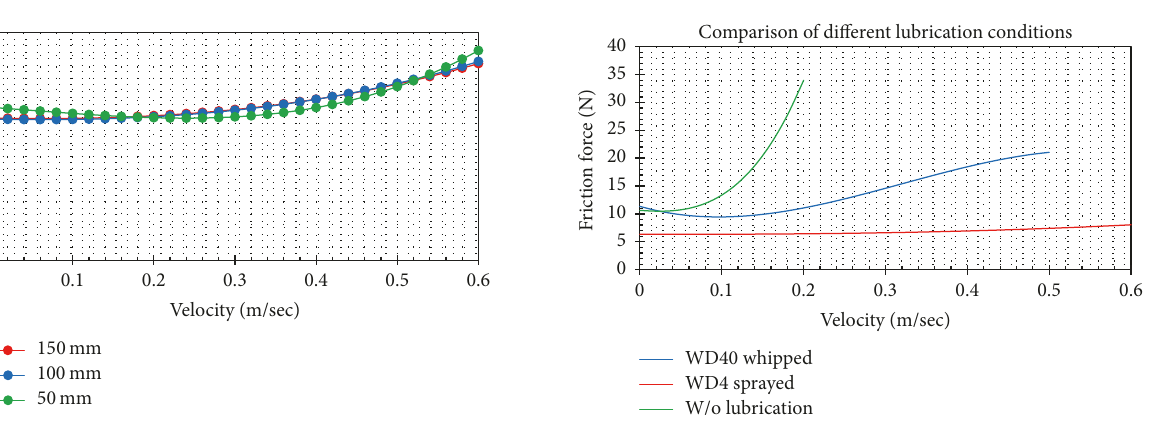
Figure 7: Function of individual best fit and friction force and function of overall best fit and friction and friction force (WD40 sprayed) with various initial displacements.